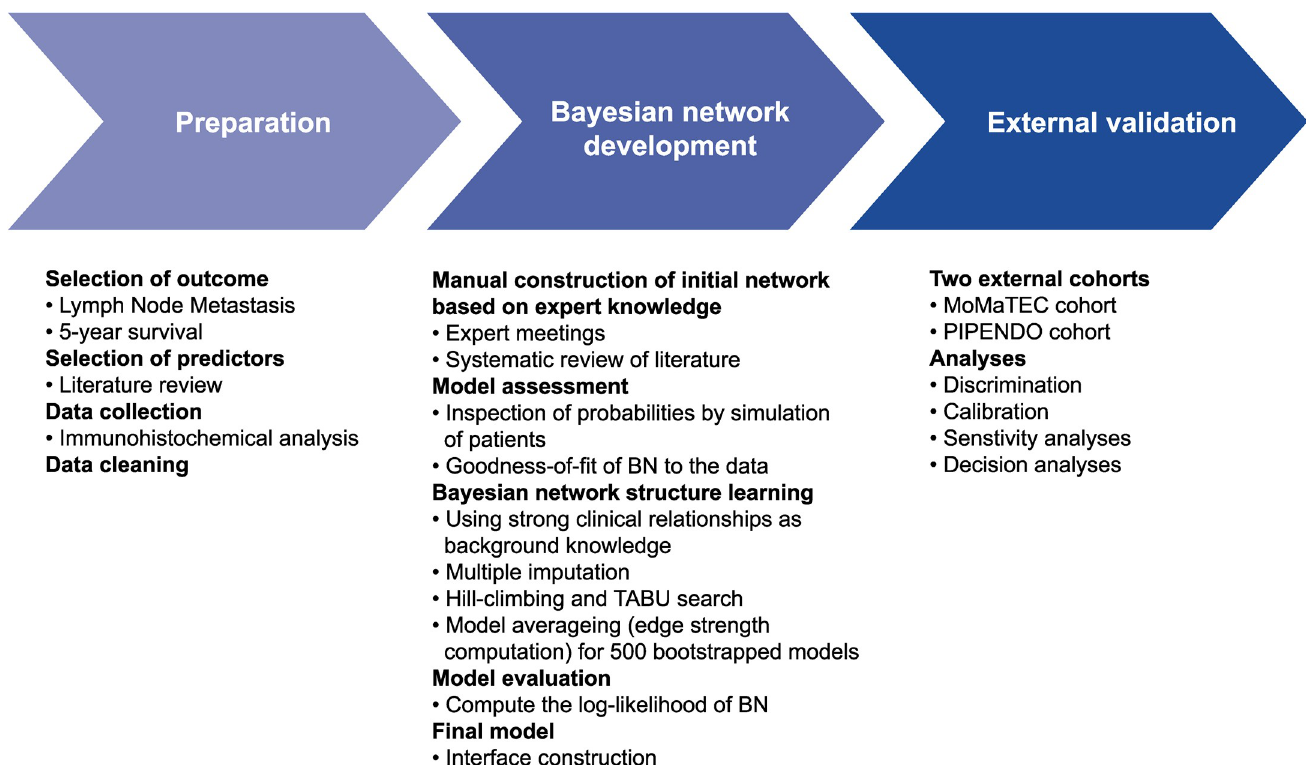
Fig 1. Summarizing overview of the BN development and validation. BN, Bayesian network; MoMaTEC, Markers for the Treatment of Endometrial Cancer; PIPENDO, PIpelle Prospective ENDOmetrial carcinoma.